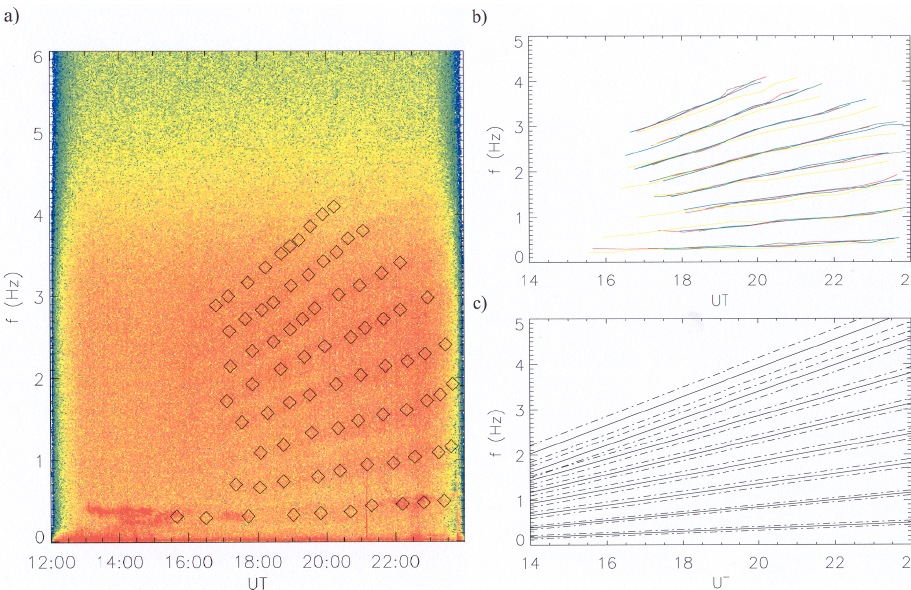
Fig. 7. Panel (a) shows pulsation magnetometer data from Sodankyl¨a, Finland for 4 October 1998 in the north south (H component) polarisation displayed as a colour dynamic power spectral plot. The black diamonds represent cursor clicks used for quantifying the diurnal evolution of the resonance features. Panel (b) shows the cursor clicked resonance features for all the polarisations on the same date with north south component (red), east west (yellow), right-handed circular (green) and left-handed circular polarisation (blue). Panel (c) shows the lines of best fit through the cursor points for each polarisation. The dot-dashed error margins are given by the standard deviation of the points about each line.